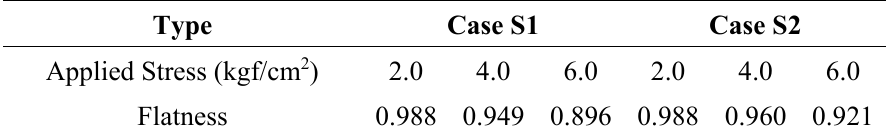
Table 4. The measured flatness of PE pipe for each case at same applied stress.